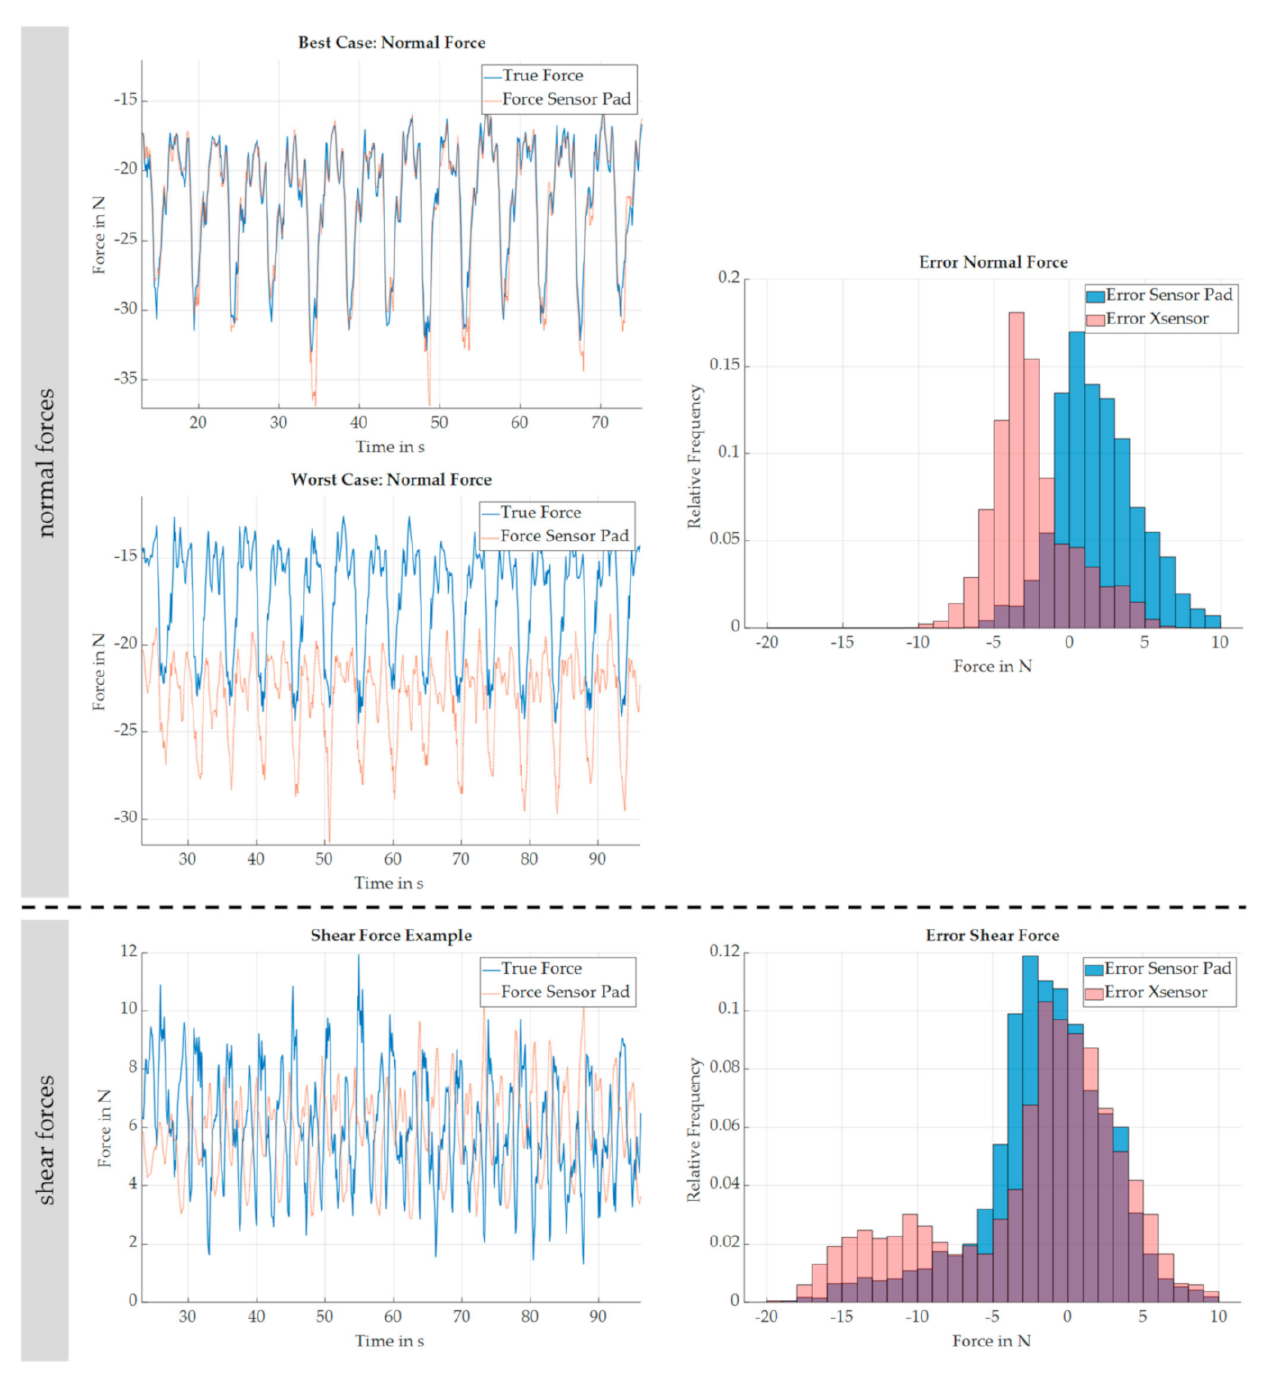
Figure 6. Comparison of measured forces in a real testing environment. Concerning the exemplary data plots ( left side), the ordinate represents the true (blue, measured by force–torque sensor) or calculated forces (red, measured by sensor pad(s)). The abscissa displays the elapsed time for the trial. Concerning the charts for the measurement-error distribution ( right side), the ordinate represents the probability of occurrence as a relative frequency. The abscissa displays the respective deviation of the pressure map (orange) and the sensor pad (blue) against the measurement of the force–torque